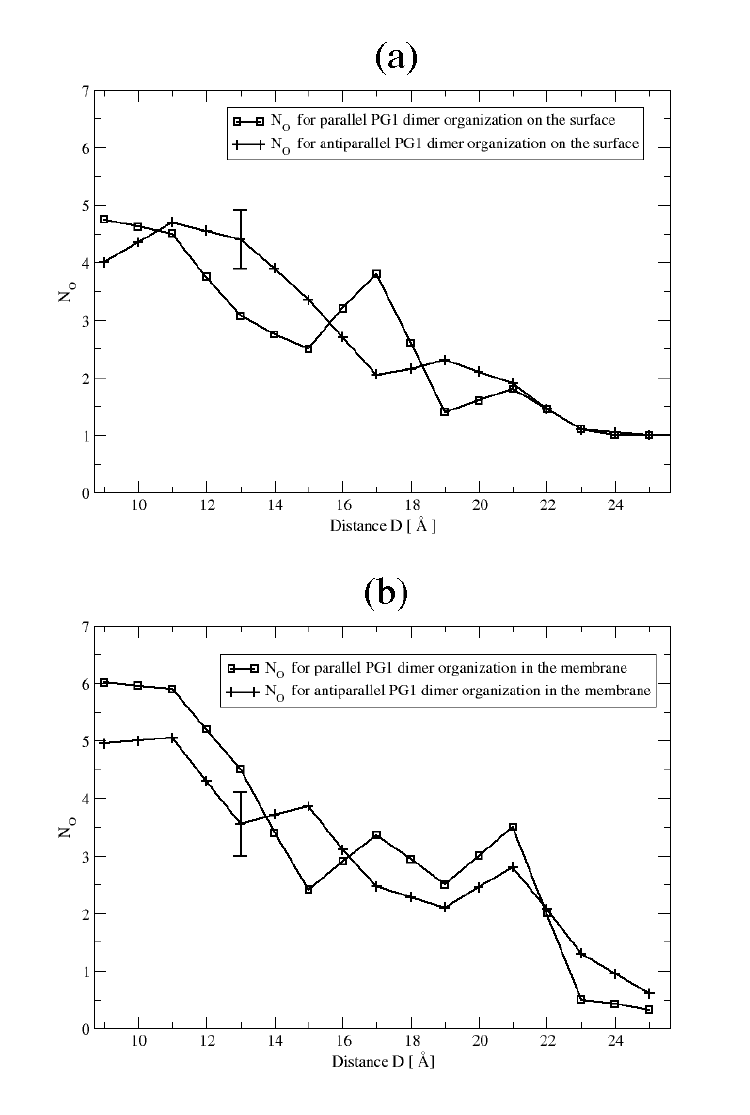
Figure 5. Average number N of anionic lipid headgroup oxygens binding to both PG1 O peptides as a function of the distance D, between the two peptides in the parallel and the antiparallel β -sheet arrangements (a) on the surface of the POPE/POPG membrane and (b) inside the POPE/POPG